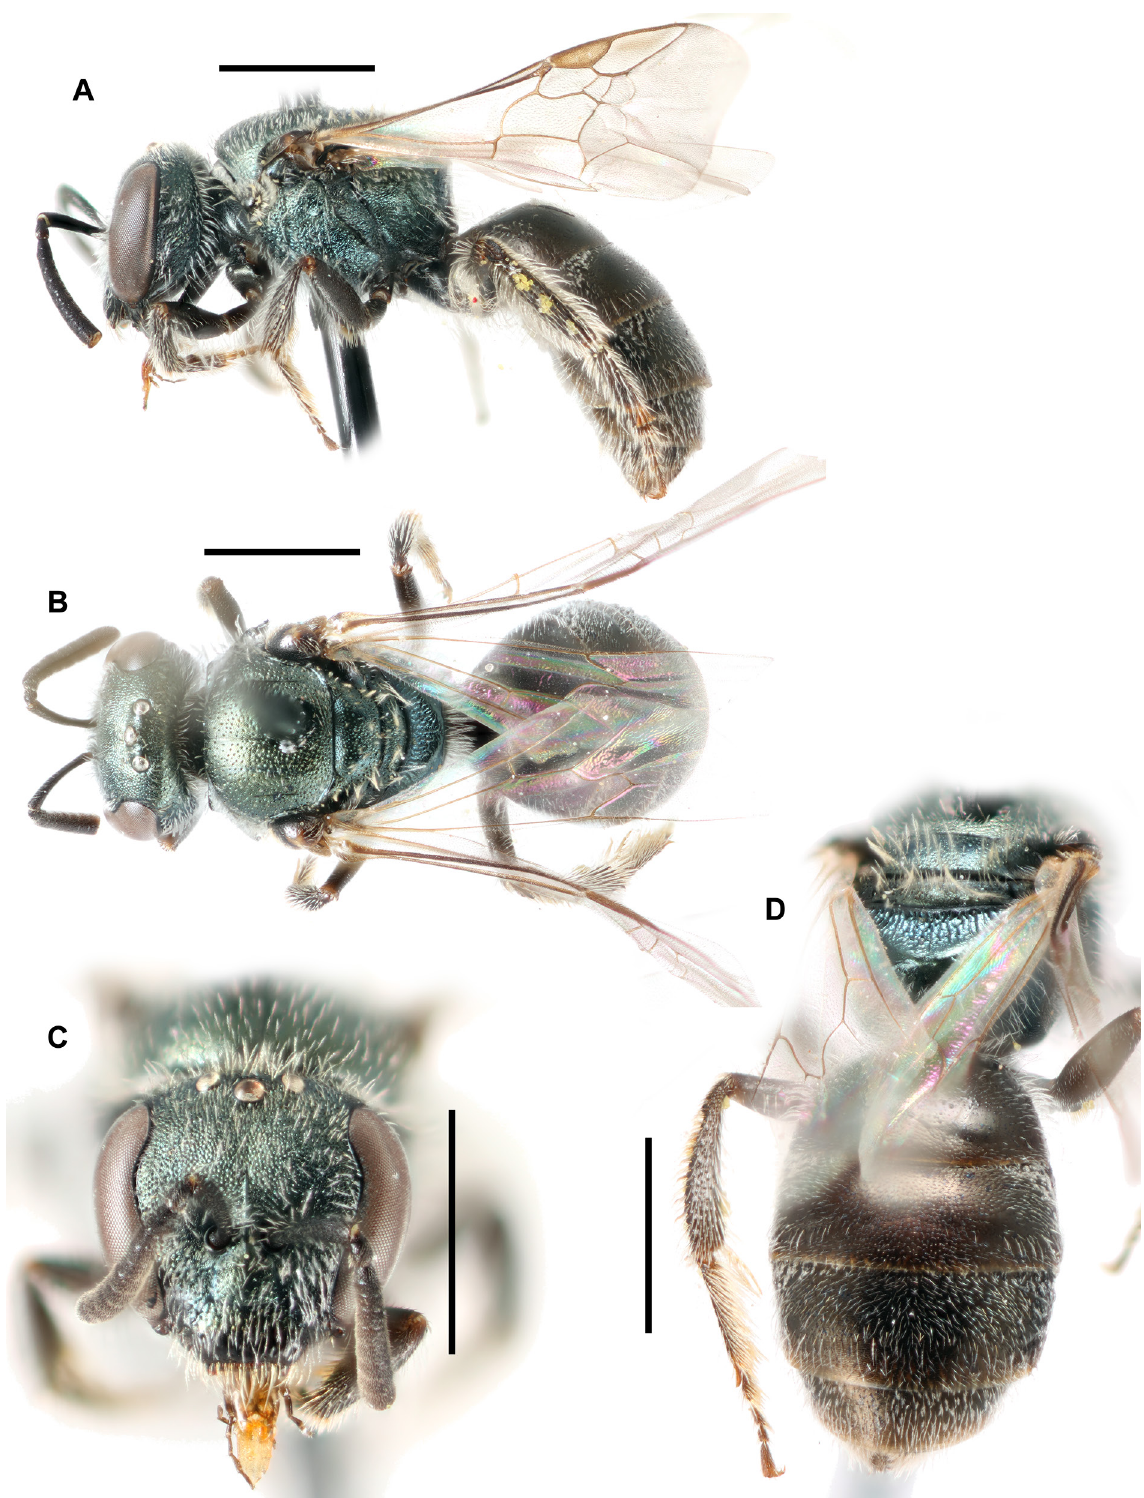
Fig. 33. Lasioglossum ( D .) holzenthali sp. nov., ♀, holotype (WRME). A . Lateral habitus. B . Dorsal habitus. C . Face. D . Metasoma and propodeum. Scale bars = 1